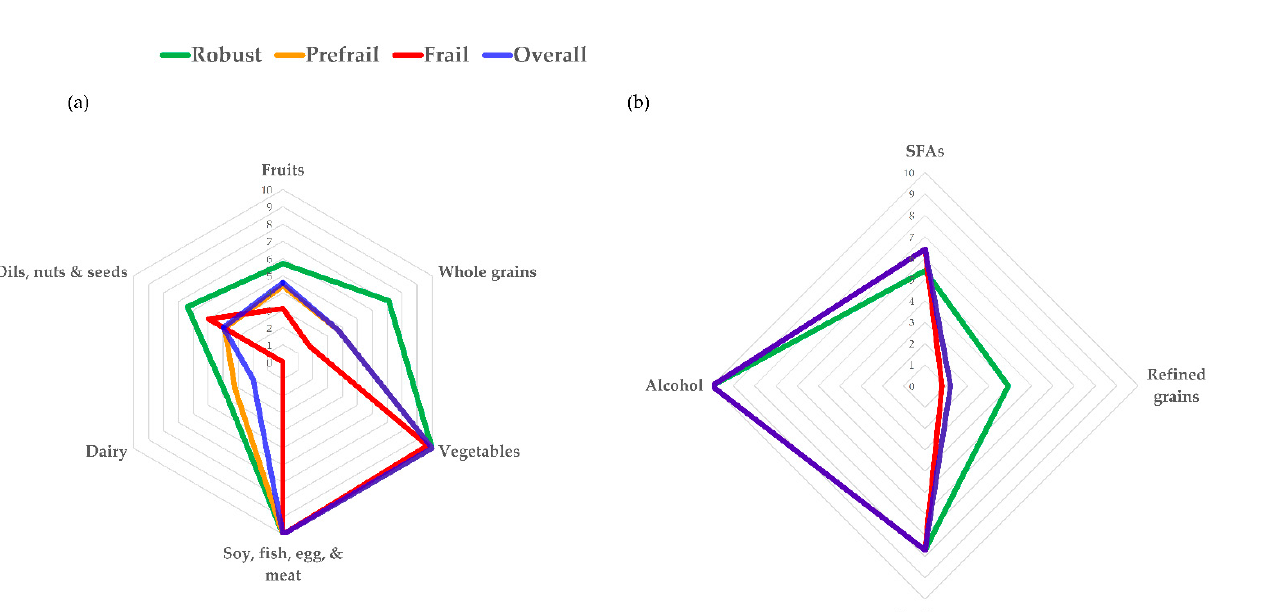
Table 4. β ± SE of frailty for 1-SD increase in each dietary quality score 1 .